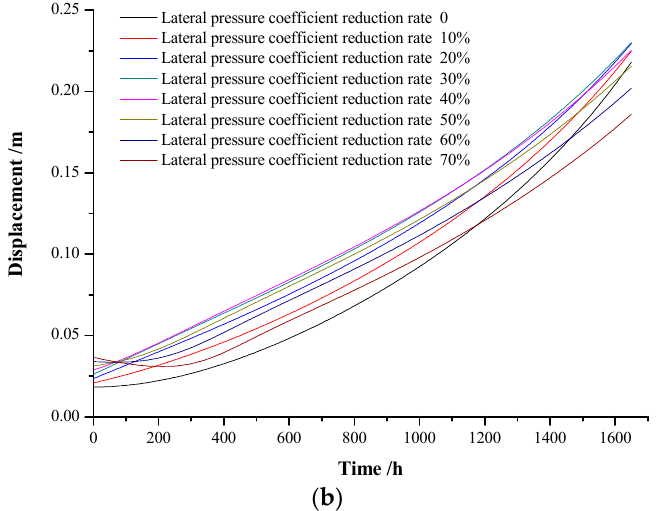
Figure 11. Variation of perimeter displacement with lateral pressure coefficient. ( a ) D3 monitoring point. ( b ) D6 monitoring point.